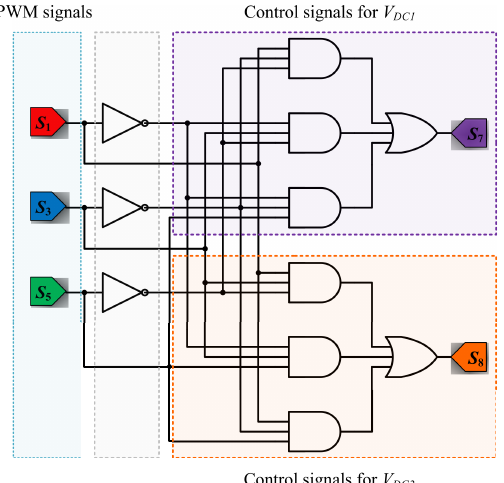
Figure 9. Digital circuit to generate the PWM signals for S7 and S8